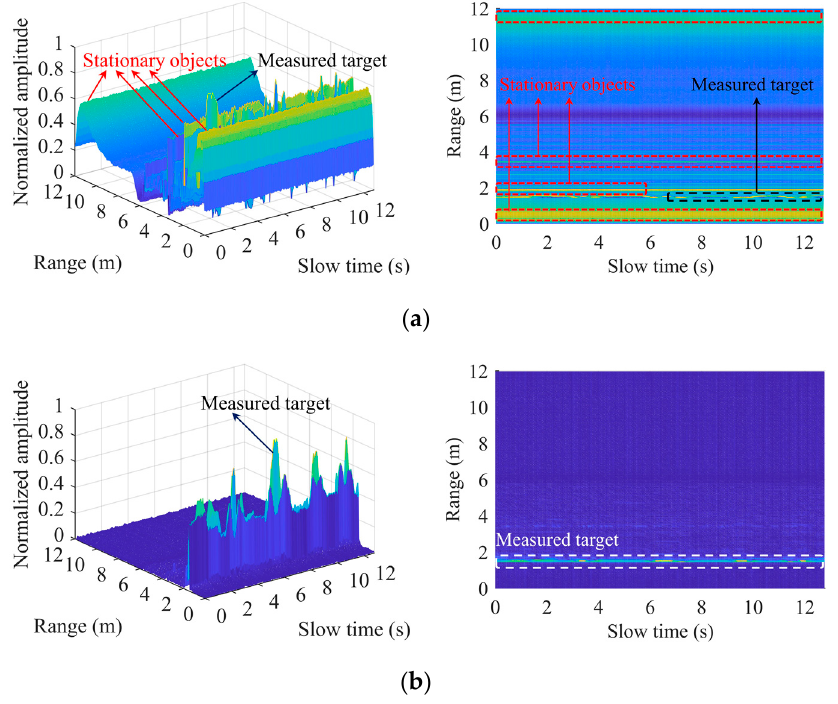
Figure 2. Range-FFT: ( a ) before static signal-clutter removal; ( b ) after static signal-clutter removal.